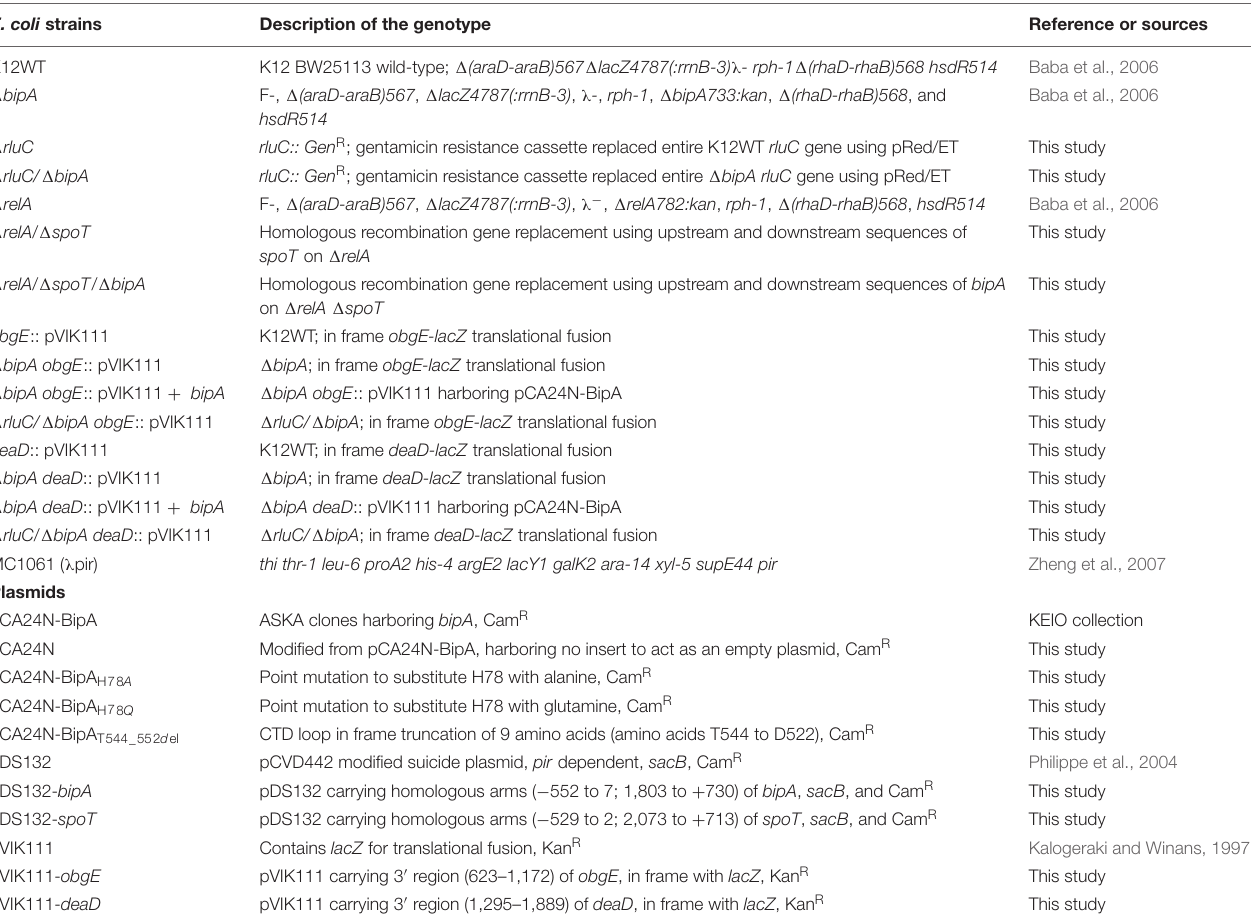
TABLE 1 | Strains of E. coli and plasmids used in this